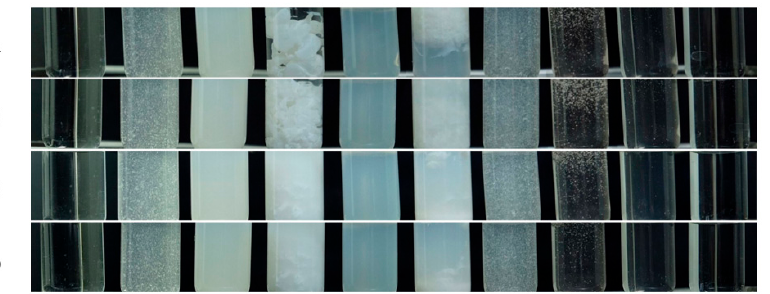
Figure 1. Physical incompatibility of lubricating gel samples exposed to CHG for ( A ) 1, ( B ) 5, ( C ) 10, and ( D ) 15 min, respectively.